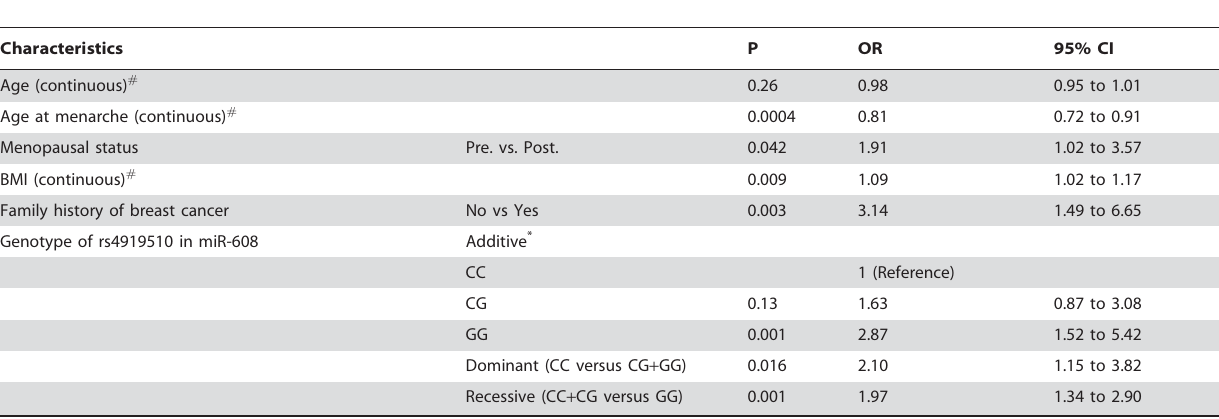
Table 3. Multivariate analysis of risk for HER2-positive breast cancer of 1,567 subjects in the first set.